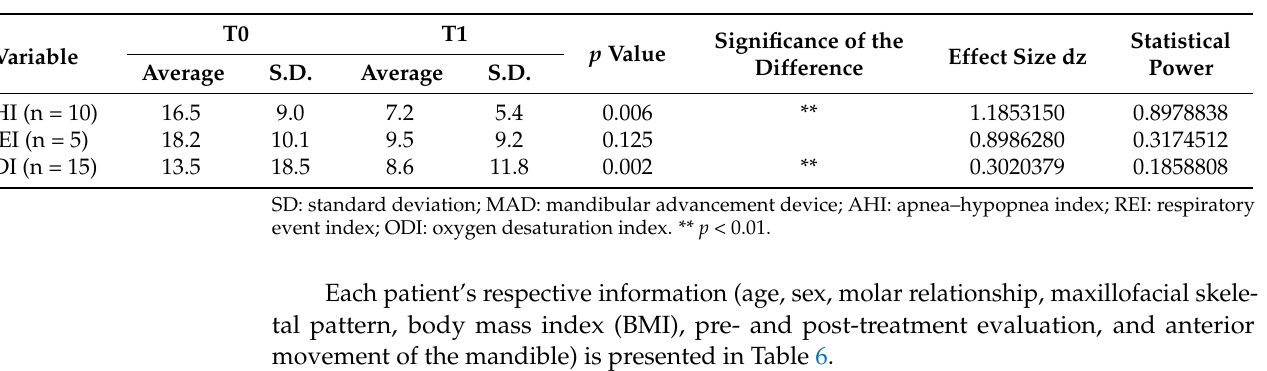
Table 6. Each patient’s respective information.